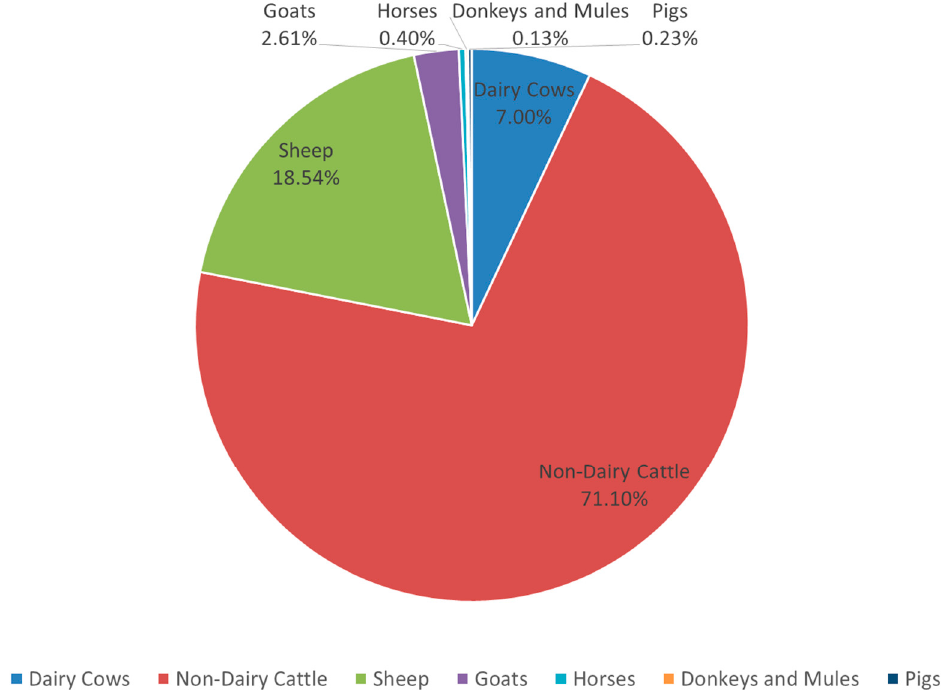
Figure 1. Proportional representations of different animal categories on enteric methane emissions from 1990–2014.